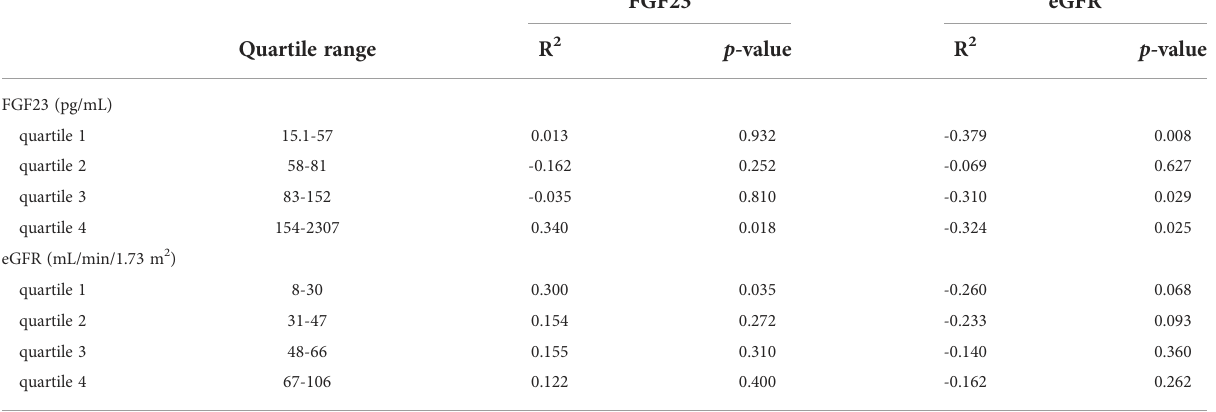
TABLE 3 Subgroup analysis of FEMg associated with FGF23 or eGFR in FGF23 or eGFR quartiles. FGF23 eGFR Quartile range R 2 p